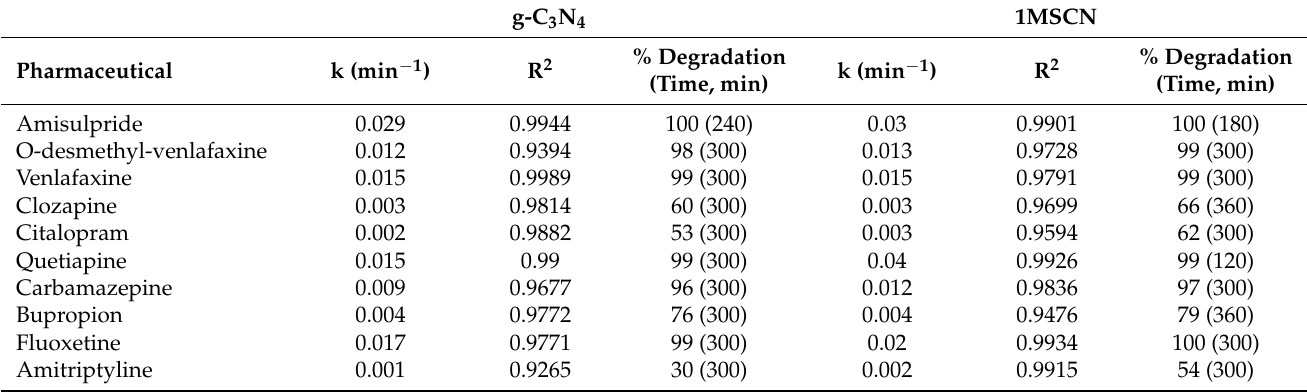
Table 1. Kinetic parameters (first-order kinetic constants (k, min − 1 ), correlation coefficients (R 2 ), and % degradation of pharmaceuticals) after photocatalytic treatment at the solar